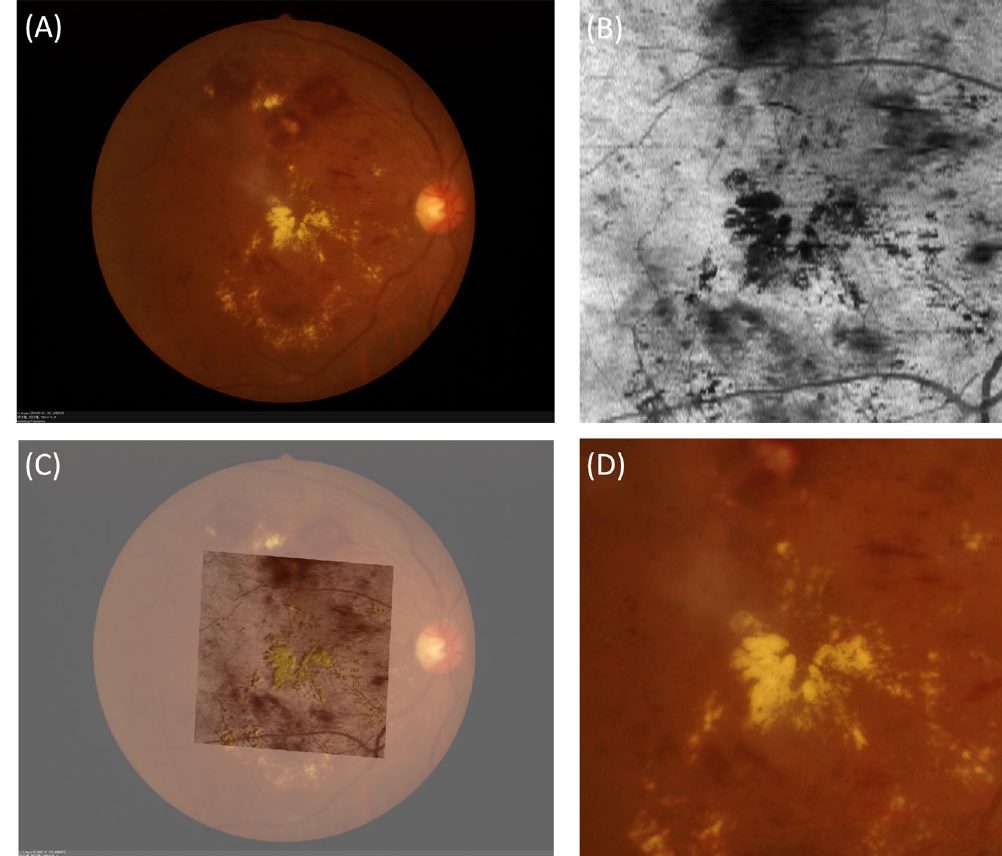
Figure 2. Registration of CFP and SD OCT en face image. ( A ) Original CFP image. ( B ) SD OCT en face image generated by projecting a region between the IS/OS and BM boundaries 33 , where the en face image can better highlight blood vessels. ( C ) SD OCT en face image is superposed on the CFP image. ( D ) The cropped CFP